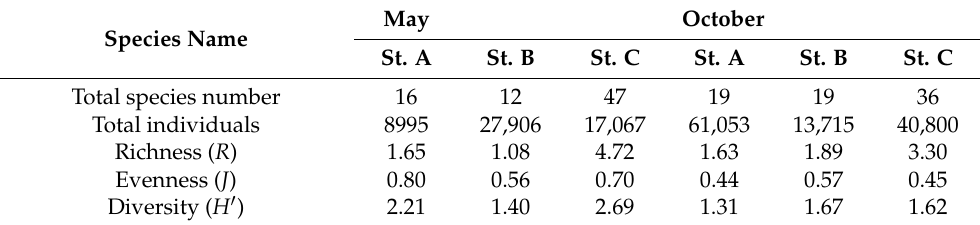
Table 2. The species number and abundance (individuals/km 2 ) and univariate ecological indices (richness, R ; evenness, J ; diversity, H (cid:48) ) of fish assemblages collected at the St. A, St. B, and St.